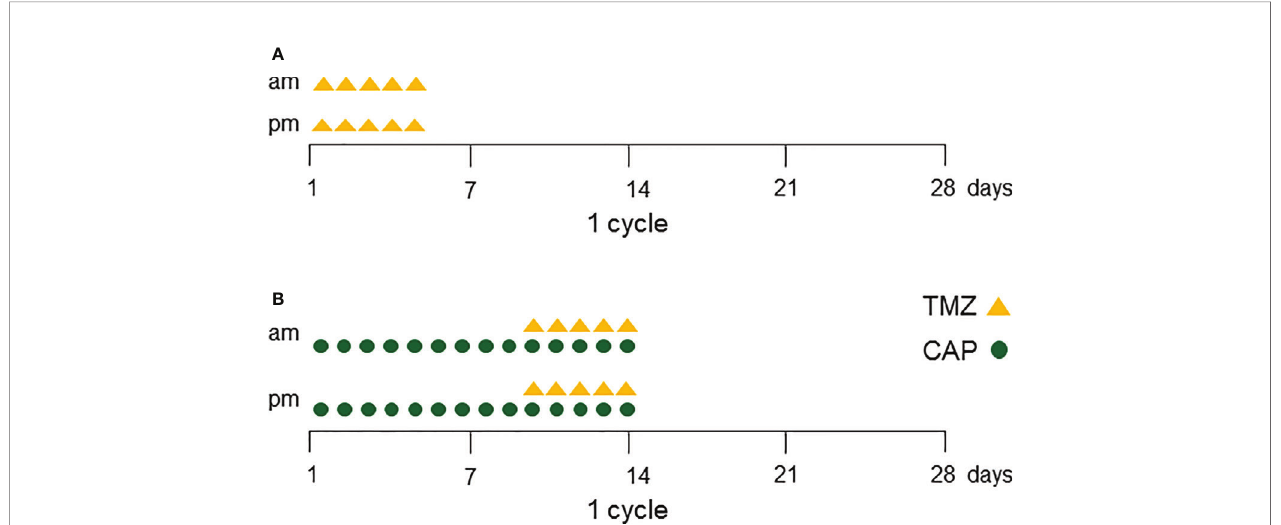
FIGURE 1 | (A) One cycle of Temozolomide (TMZ) protocol. TMZ is given twice daily (150 – 200 mg/m 2 /day) for 5 consecutive days every 28 days (=1 cycle). After three cycles of TMZ, MRI is taken for treatment evaluation. Continue TMZ at least six cycles in total for responder patients. (B) One cycle of Capecitabine (pro-drug of 5-Fluorouracil) + Temozolomide (CAPTEM) protocol. Oral capecitabine (CAP) is given (1,500 mg/m 2 /day) on days 1 through 14 divided into two doses, and TMZ is given twice daily (150 to 200 mg/m 2 /day) on days 10 through 14. This 2-week regimen is followed by 2 weeks off treatment. Continue CAPTEM at least 12 cycles in total for responder